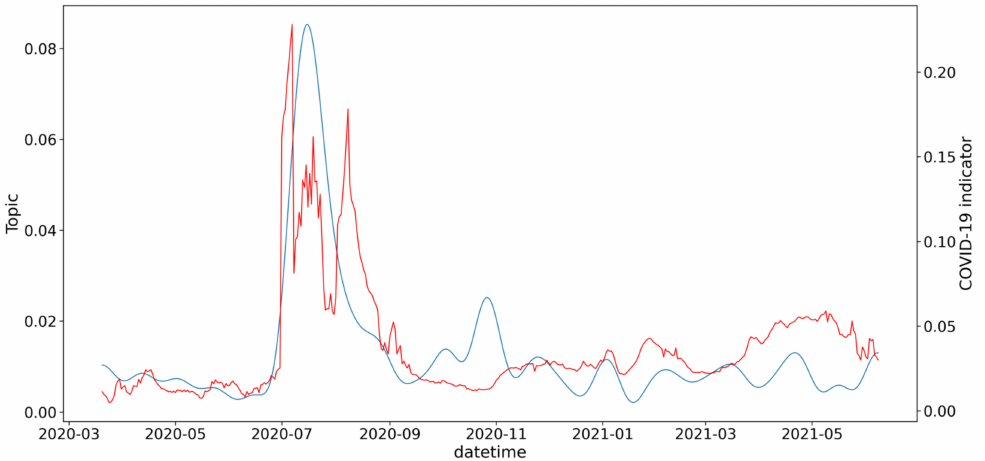
Figure 7. The red line represents the COVID-19 positive rate, and the blue line represents the dynam- ics of topic “Medication, Medicinal, Drug, Medication, Medicinal_medication, Medical, Pharmacy”.